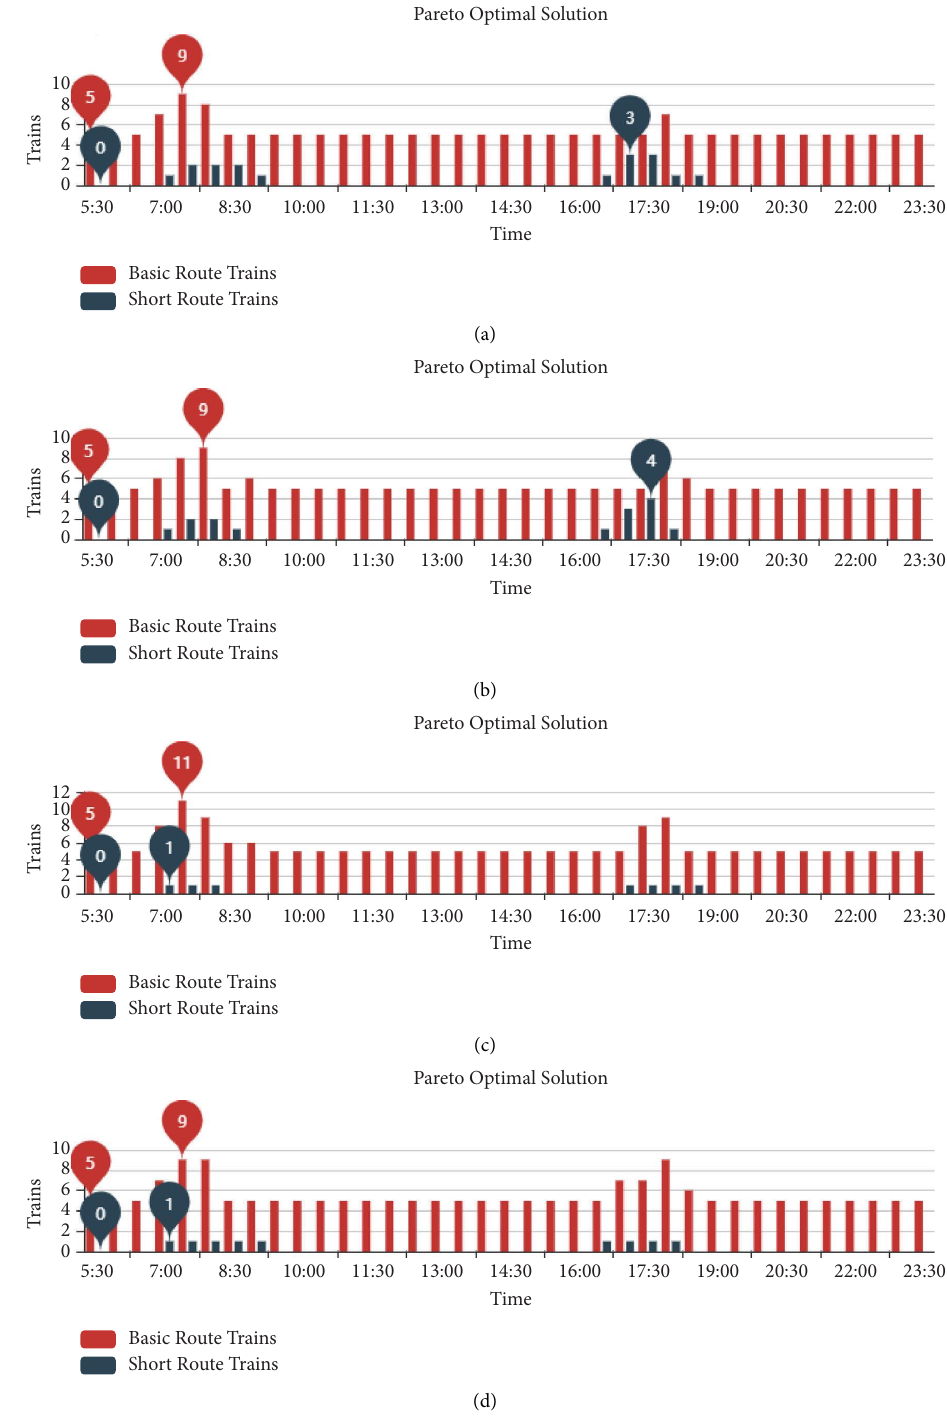
Figure 10: Capacity allocation of Pareto optimal schemes. (a) Pareto scheme 1, (b) Pareto scheme 2, (c) Pareto scheme 3, and (d) Pareto scheme